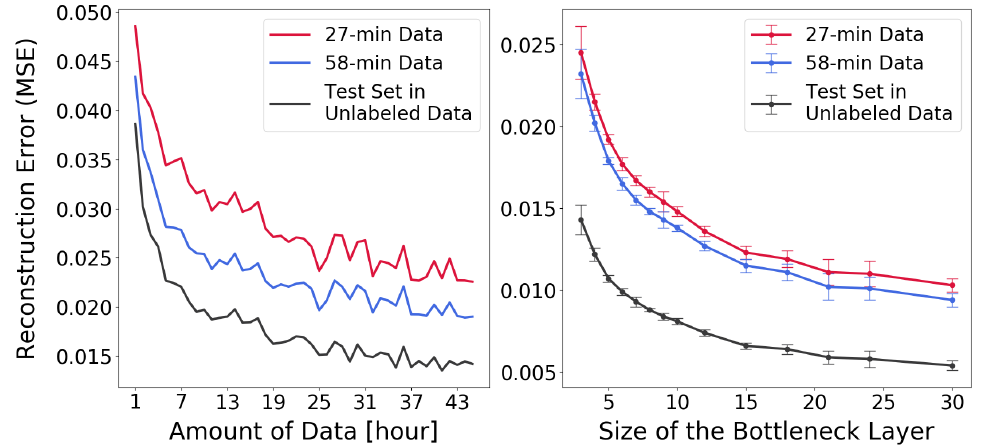
Figure 5. Reconstruction performance on the hold-out (unlabeled) test data from the Norway site and the two labeled datasets from the Swedish site, based on ( left panel ) adding more data during training and ( right panel ) increasing the bottleneck